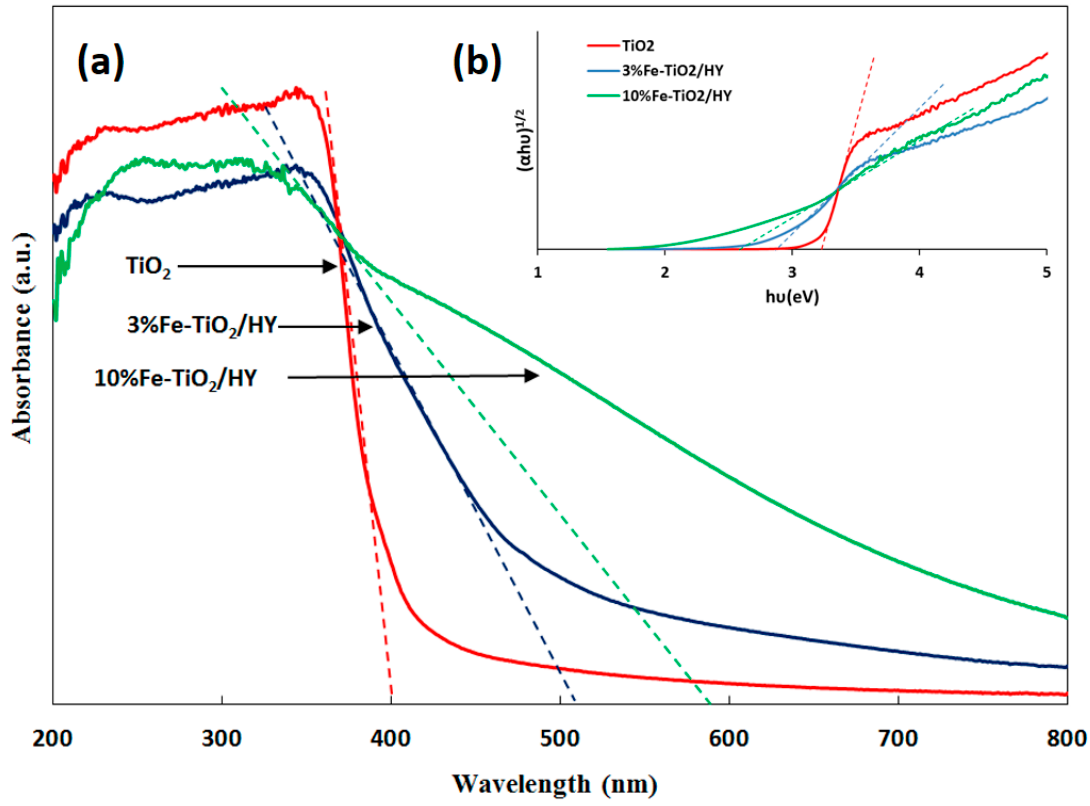
Figure 7. ( a ) UV-VIS diffuse reflectance spectra before and after doping with Fe; and ( b ) the Figure 7. ( a ) UV ‐ VIS diffuse re fl ectance spectra before and after doping with Fe; and ( b ) the corresponding Kubelka-Munk-transformed diffuse reflectance, as a function of h υ corresponding Kubelka ‐ Munk ‐ transformed diffuse re fl ectance, as a function of h υ .